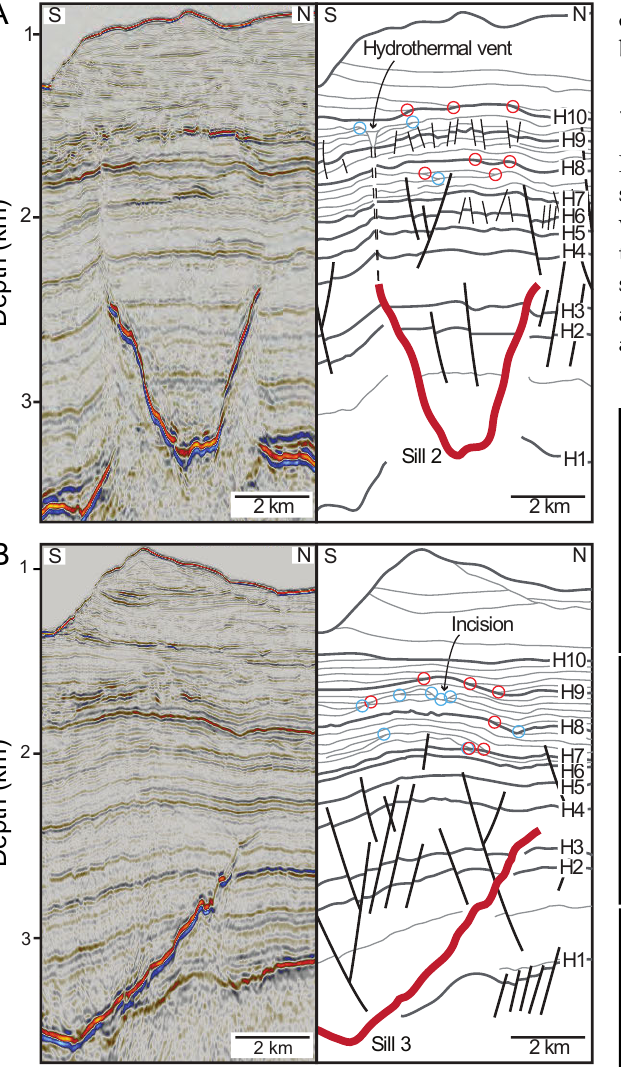
Figure 7: Seismic sections and line interpretations through [A] S2 and Fold 2, and [B] S3 and Fold 3. See Figure 5 for locations.